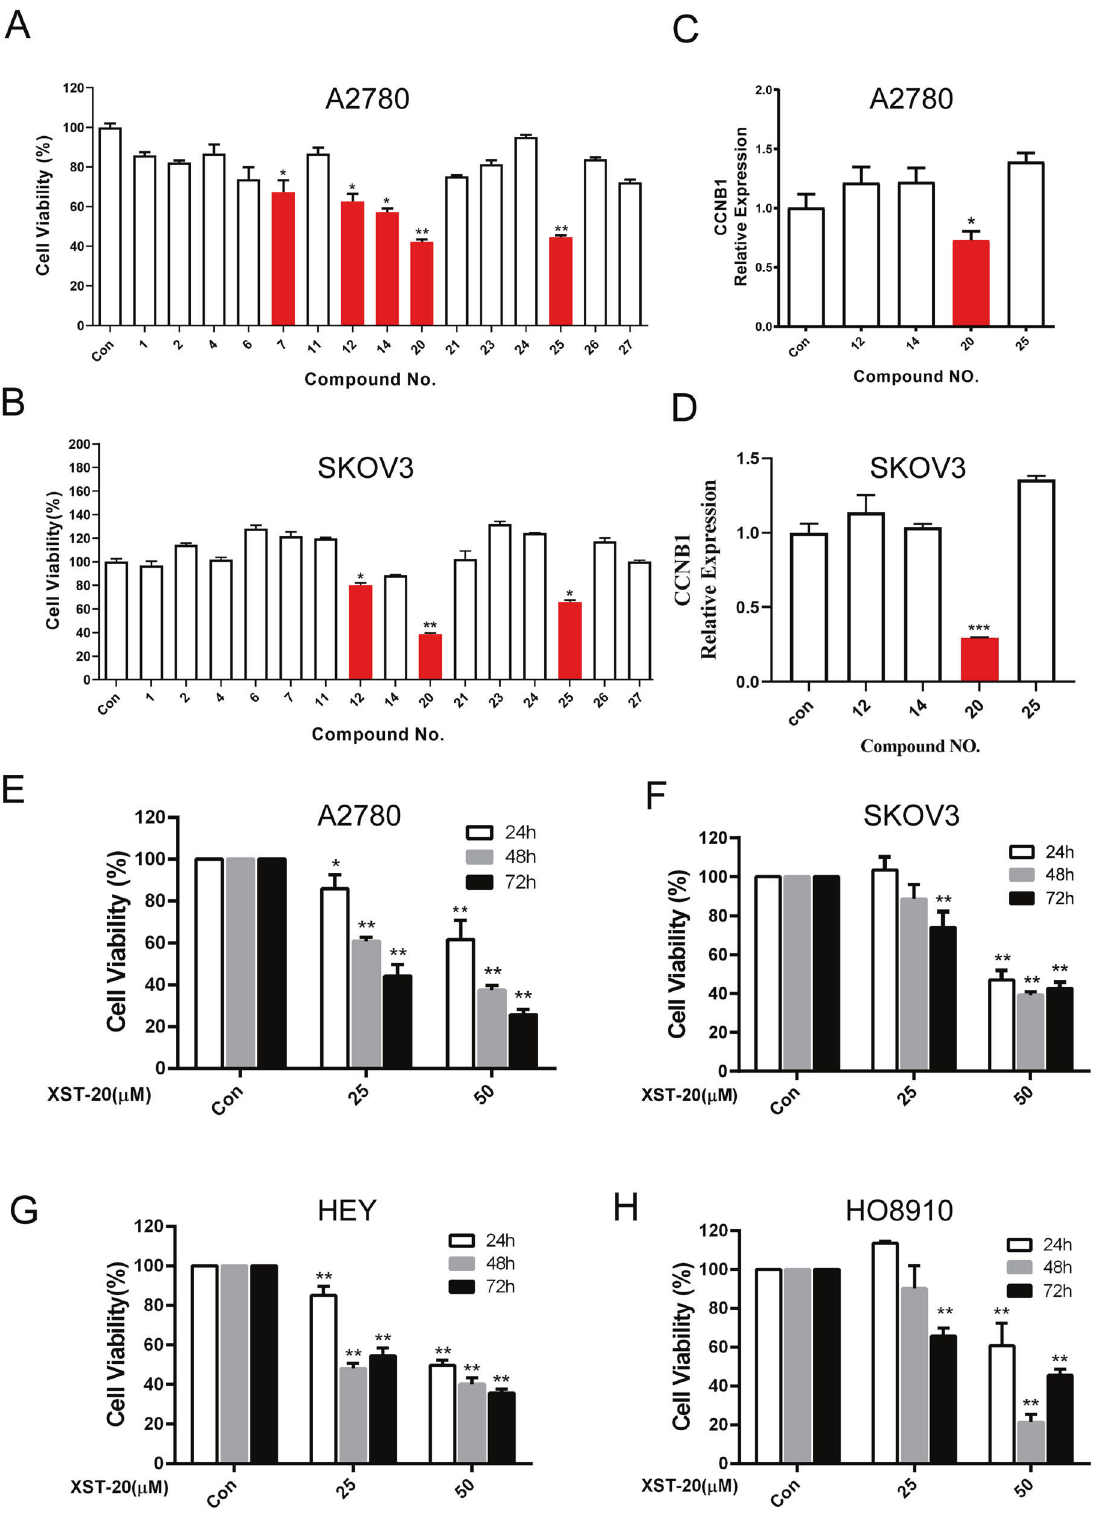
Fig. 2 Validation of small molecular compounds that inhibit FOXM1. A , B The inhibitor effect of 15 candidate compounds on ovarian cancer cell lines were measured by MTT assay. C , D Expression level of CCNB1 was detected by qPCR in A2780 cells treated with compounds. E – H Inhibitor effect of XST-20 on four ovarian cancer cell lines was evaluated by MTT assay. Data were presented as means ± S.D. * p < 0.05, ** p < 0.01, *** p < 0.001, and **** p < 0.0001.